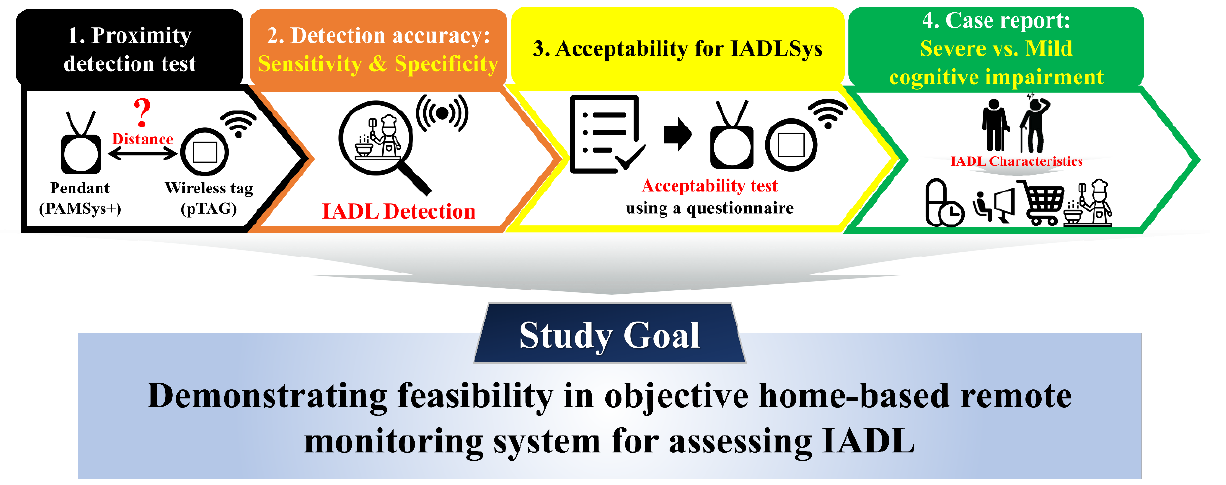
Figure 4. Flow-chart for the validity test.